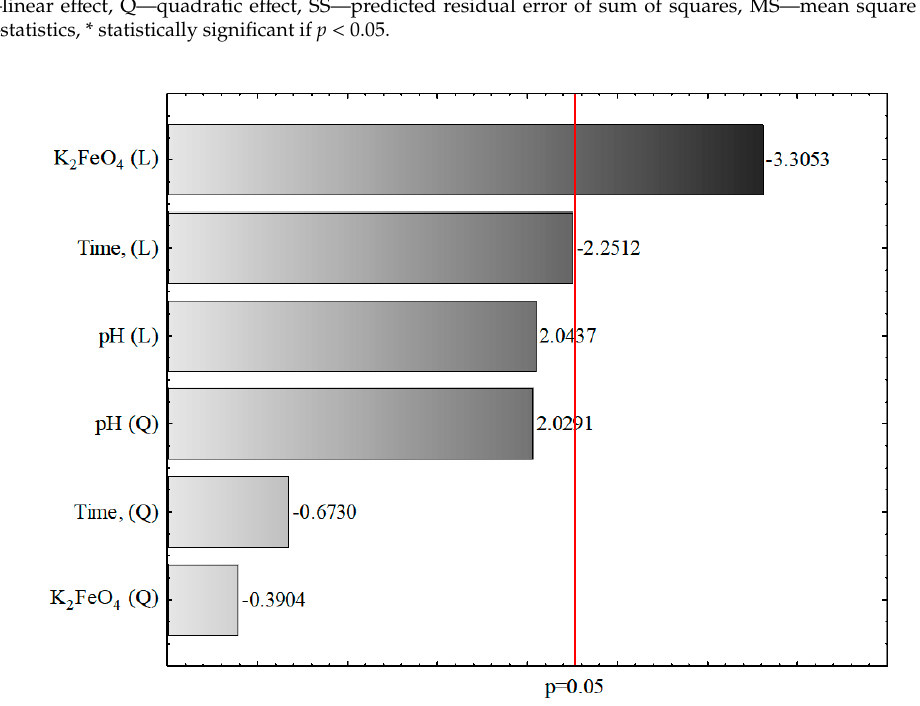
Figure 2. Bar chart of standardized e ff ects (COD, g O 2 / L, 3 value, 1 block, 16 experiments, MS = 3.4812, Figure 2 . Bar chart of standardized effects (COD, g O 2 /L, 3 value, 1 block, 16 experiments, MS = L—linear e ff ect, Q—quadratic e ff ect, p —the absolute value of the standardized e ff ect 3.4812, L—linear effect, Q—quadratic effect, p —the absolute value of the standardized effect assessment).